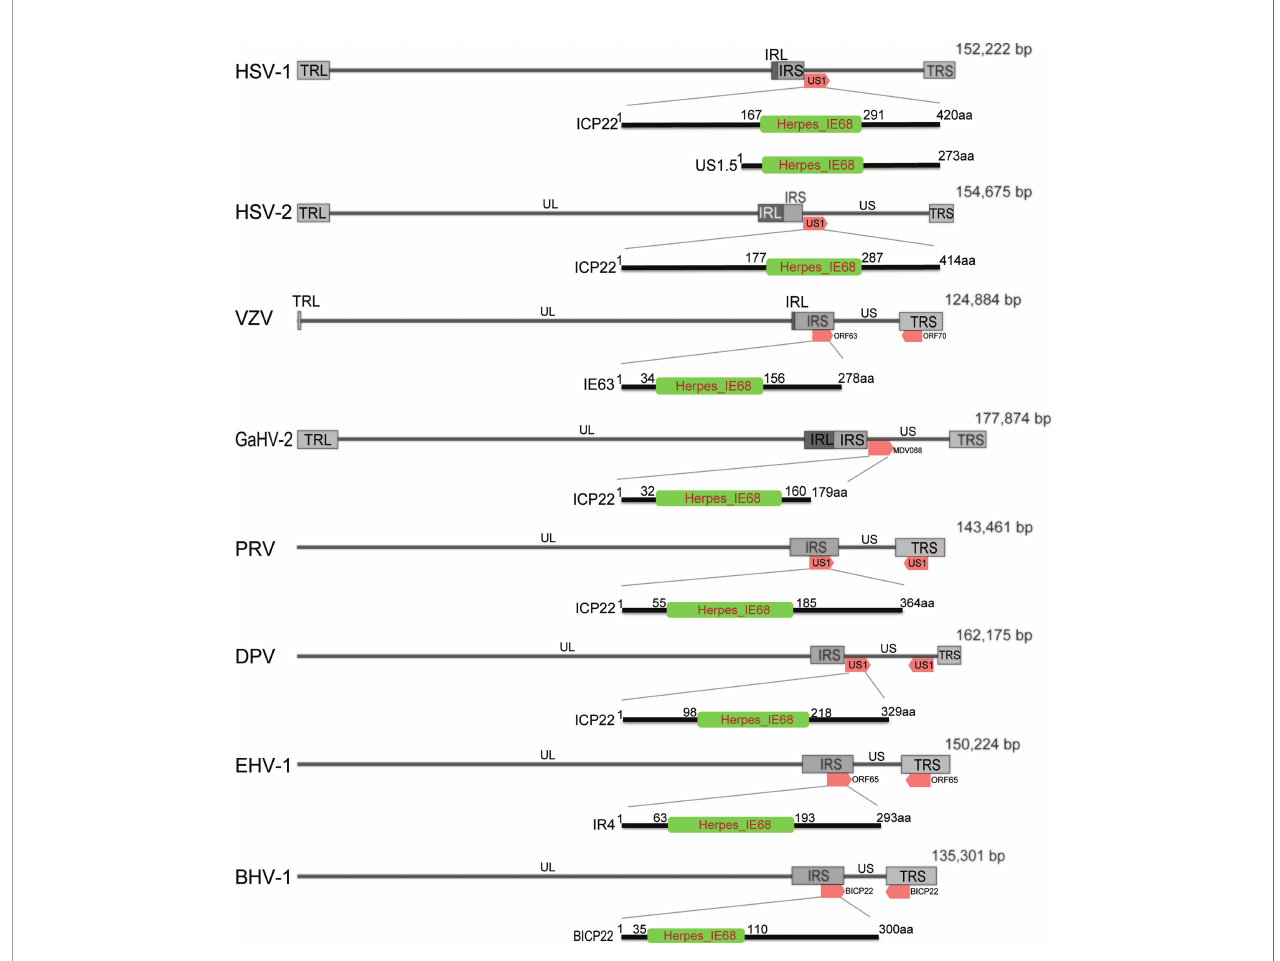
FIGURE 1 | Schematic diagram of the position of ICP22 homologs in the a -HV genome. The a -HV genome is composed of unique long (UL), unique short (US), terminal repeat sequence (TRS) and internal repeat sequence (IRS). ICP22 homologs are located in the US or repeat sequence of the genome. The HSV-1, HSV-2, and GaHV-2 ICP22 genes are located in the US region of the viral genome and are single-copy genes; VZV, PRV, BHV-1, and EHV -1 ICP22 contain two copies, located in two inverted repeats of the genome. DPV ICP22 contains two copies, located in the US region of the genome. They all contain a conserved Herpes_IE68 domain, which is an immediate early